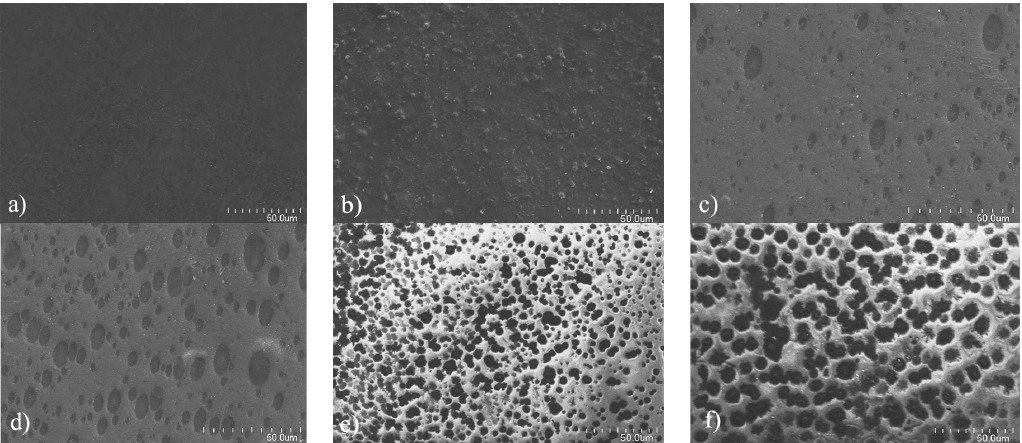
Figure 5. Surface morphologies of PMPU-10 film in PBS (pH = 7.4) at 37 ± 0.1 °C after ( a ) 0, ( b ) 3, ( c ) 5, ( d ) 7, ( e ) 10, and ( f ) 12 days of degradation.